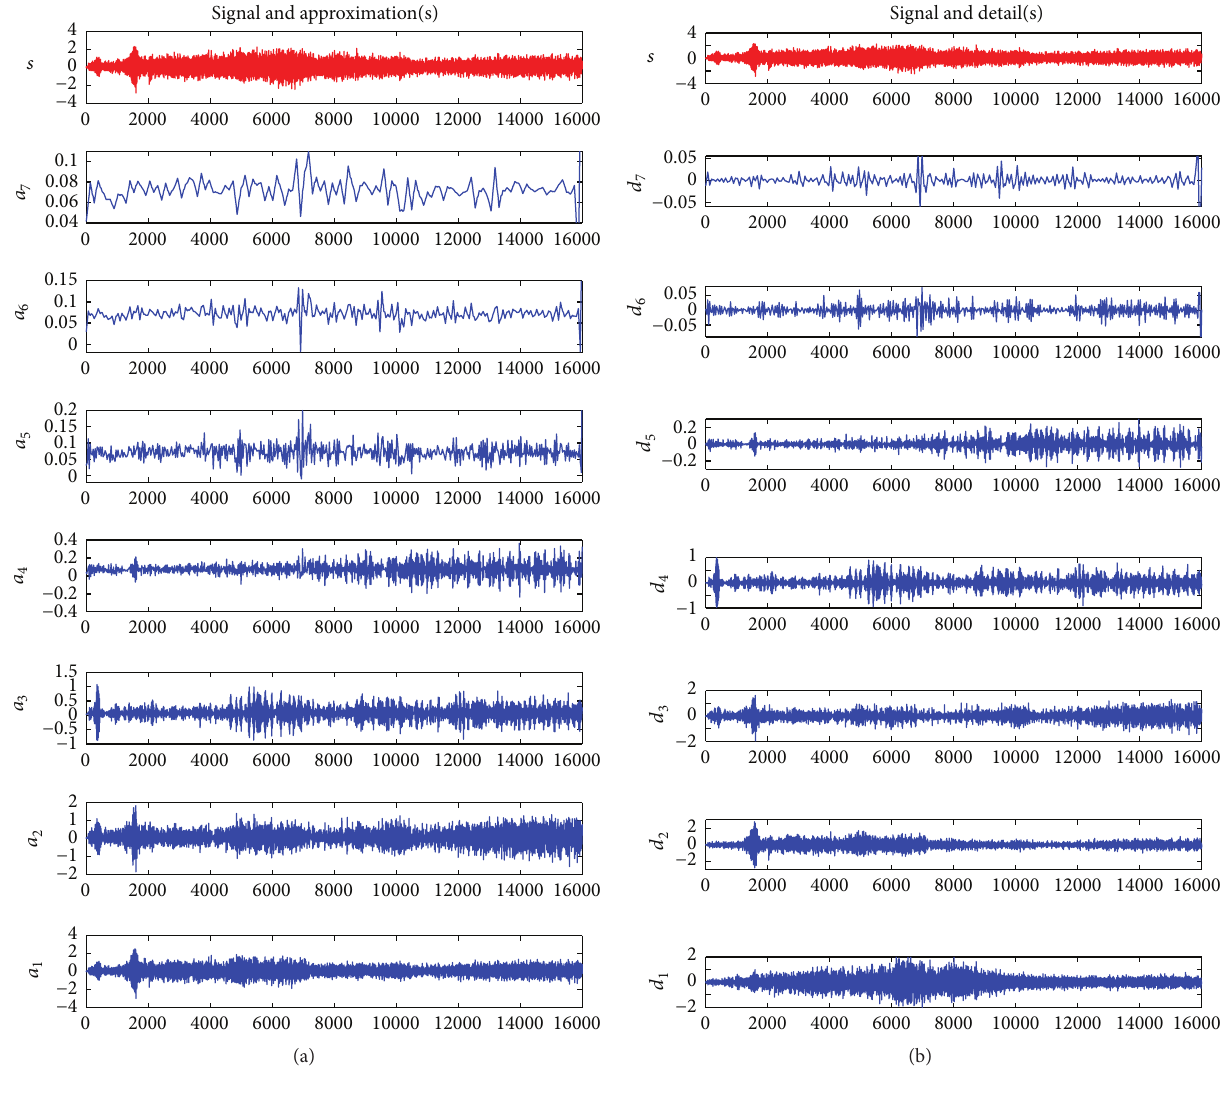
Figure 2: DWT decomposition, (a) approximation, and (b) detail.